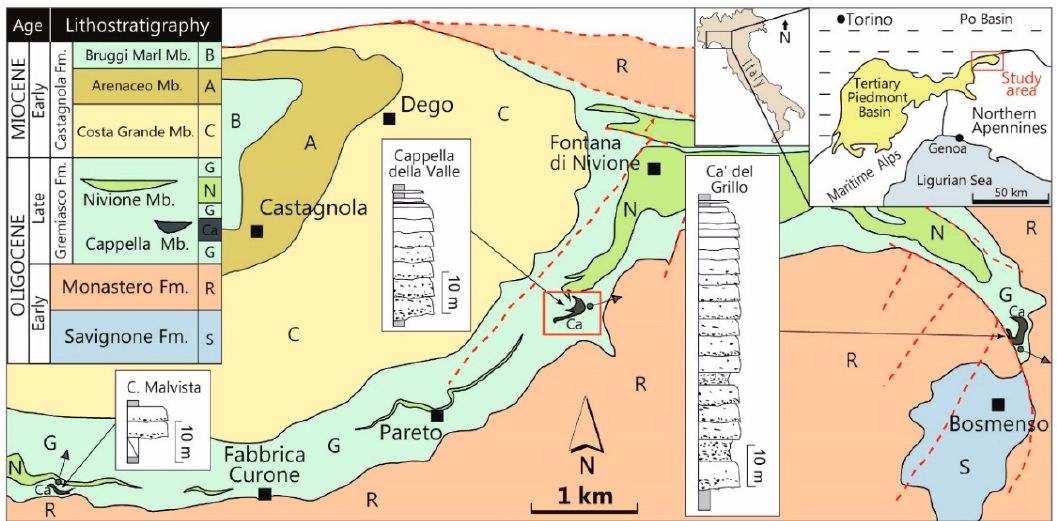
Figure 1. ( a ) Simplified geological map (modified, after Cavanna et al. [40]) of the easternmost part of the Tertiary Piedmont Basin sedimentary (lithostratigraphy after Marroni et al. [41]; upper left corner) with location and synthetic sedimentary logs (modified, from Di Giulio and Galbiati [42]) of the three outcrops of the Cappella della Valle Mb. with average paleoflow direction (arrows). The red box indicates the studied outcrop.